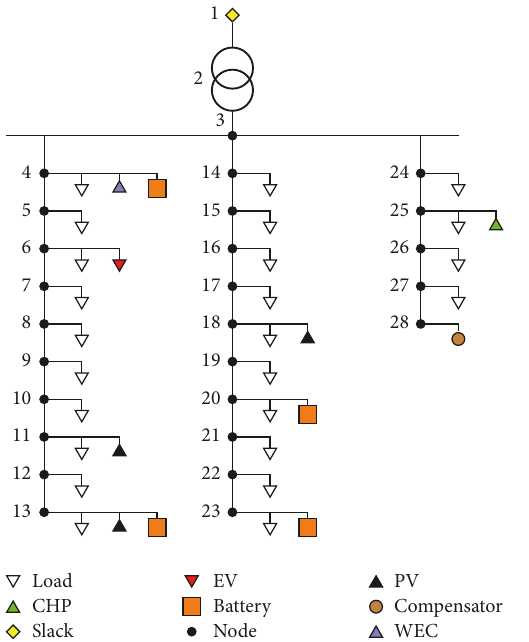
Figure 8: Low voltage distribution system for evaluation of correct- ness of distributed forward-backward sweep implementation.